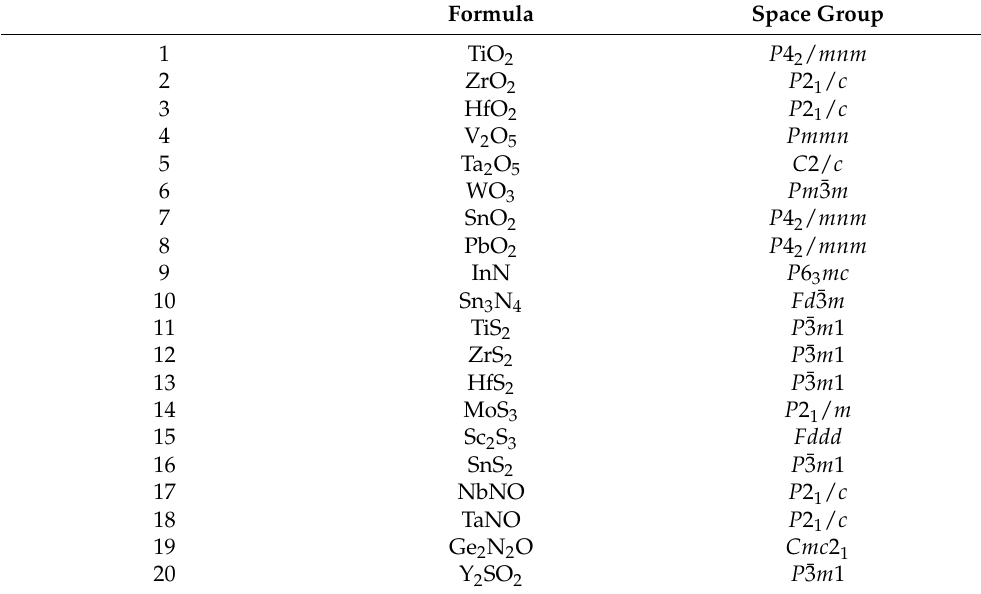
Table 1. Chemical formula and space group for each of the materials in this benchmark study.